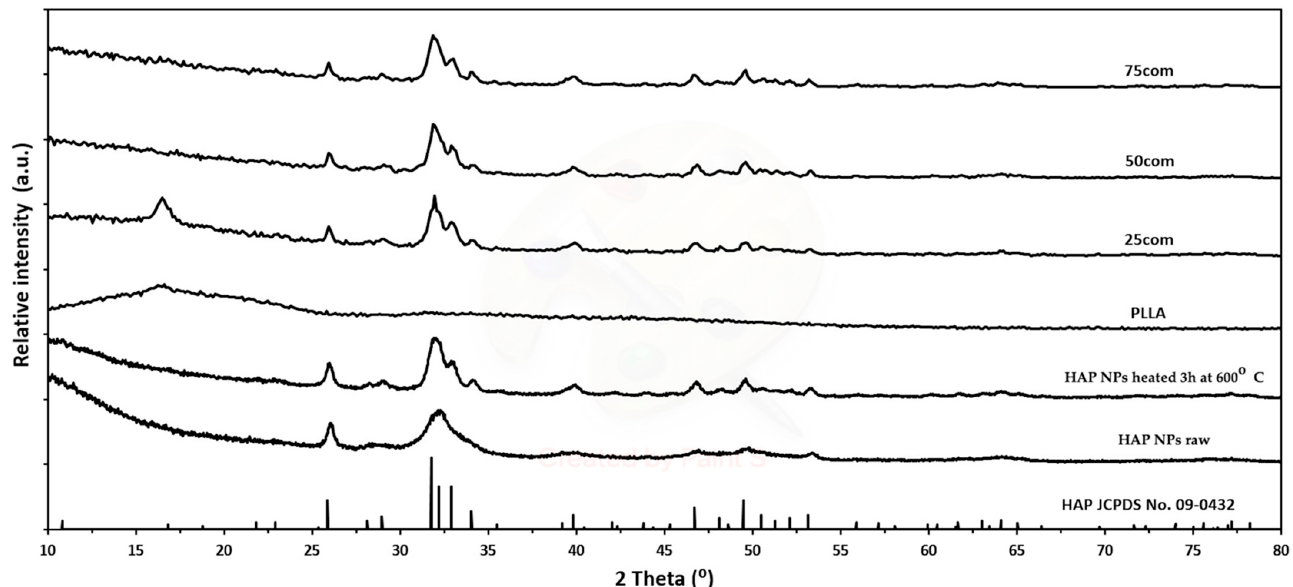
Figure 2. XRD of the HAP NPs (raw), HAP NPs (heated at 600 ◦ C) powder and of the composite after warm isostatic pressing at 170 °C.